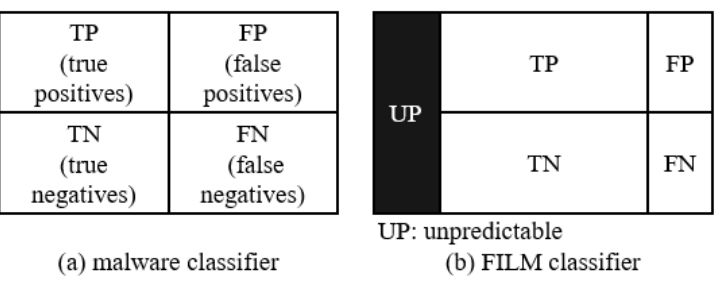
Figure 2. Comparison of prediction types, existing malware classifier vs. FILM. A new type of unpredictable appears in FILM.